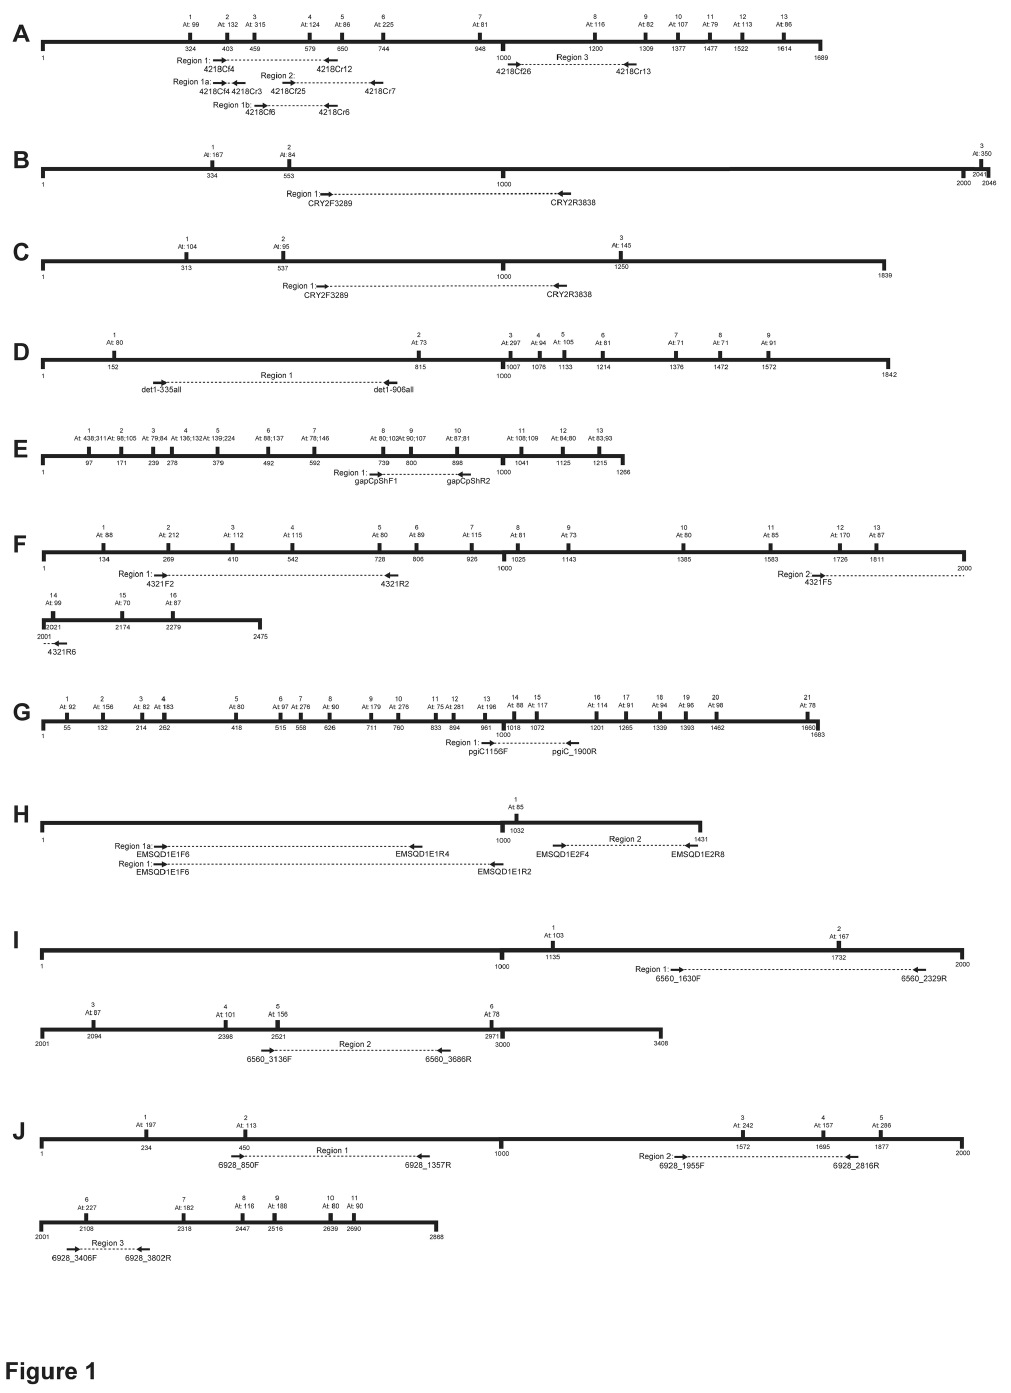
Figure 1. Schematic diagrams of the ten nuclear genes for which we developed fern-specific primers. (A) ApPEFP_C ; (B) CRY2 ; (C) CRY4 ; (D) DET1 ; (E) gapCpSh ; (F) IBR3 ; (G) pgiC ; (H) SQD1 ; (I) TPLATE ; (J) transducin . Each subset of the figure represents one protein-coding locus, using the most closely related Arabidopsis thaliana homolog as the template. The coding sequence is measured (in base pairs) along the bottom of the thickened horizontal line, with each locus wrapping onto a new line every 2000 base pairs, when necessary. Intron location, number, and length (in base pairs in Arabidopsis ) are given above the line. Also shown below the line are the priming locations for each of the markers we developed. For gapCpSh , intron locations are based on Arabidopsis gapCp1 : the first two exons of Arabidopsis gapCp2 are each one codon shorter than in gapCp1 . doi: 10.1371/journal.pone.0076957.g001 PLOS ONE |